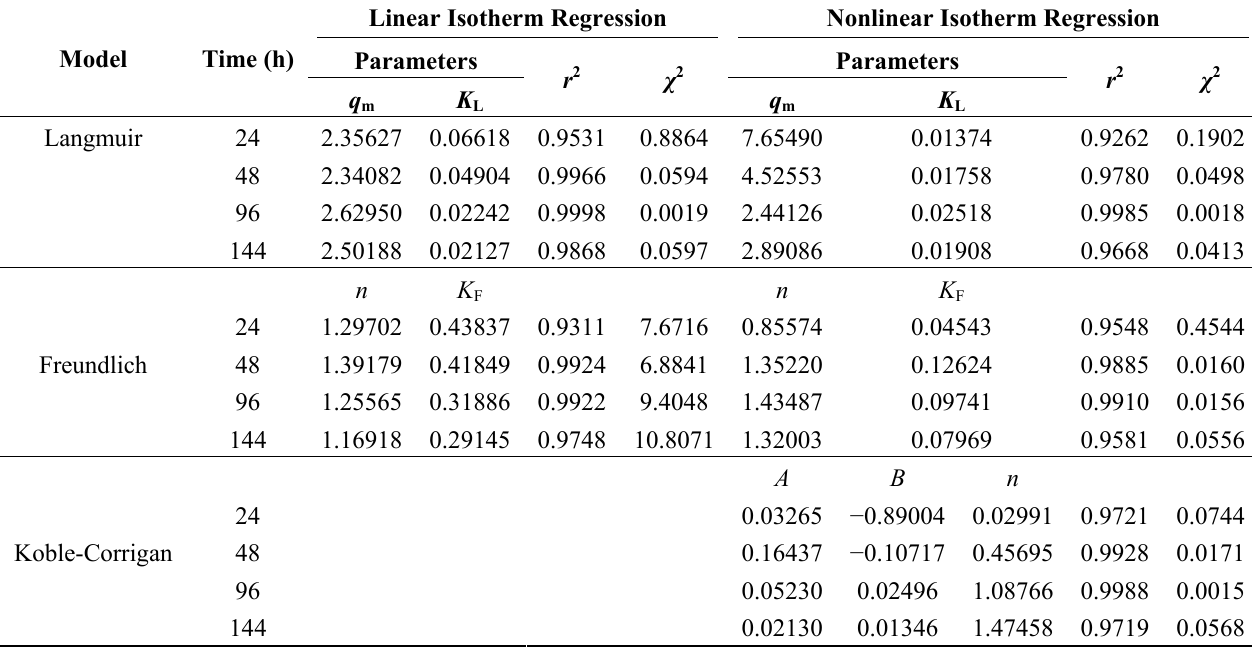
Table 2. The equilibrium isotherm model